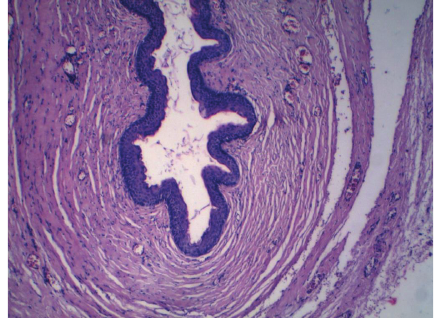
Figure 3: Histopathological appearance of the epidermoid cyst lined by stratified squamous epithelium and filled with keratinous material (H&E ×